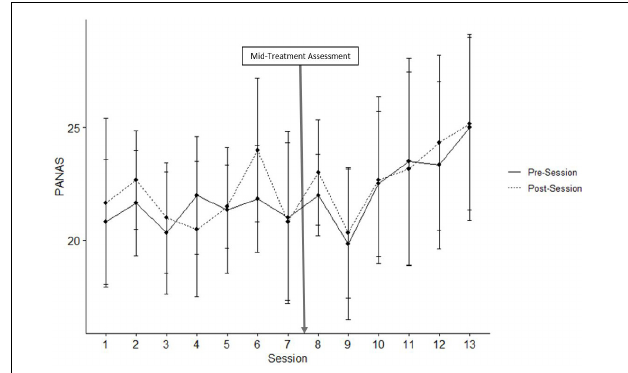
FIGURE 2 | Positive PANAS. Mean scores of positive item responses on the PANAS before and after all thirteen VR sessions. Error bars represent standard error of the mean.